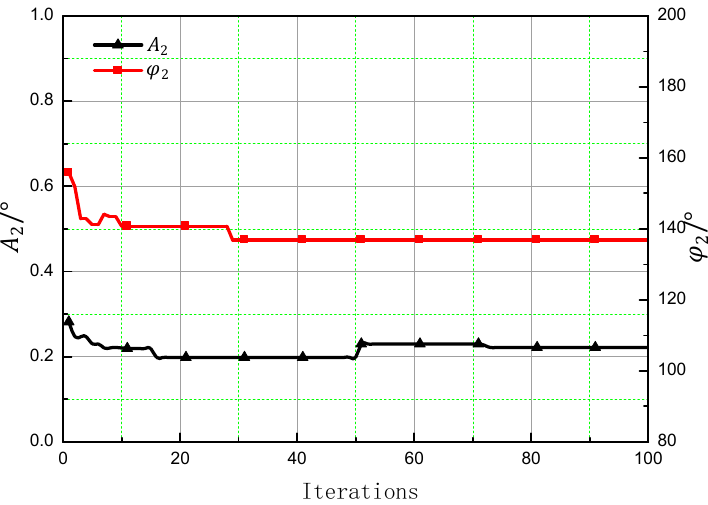
Figure 11. The final population.